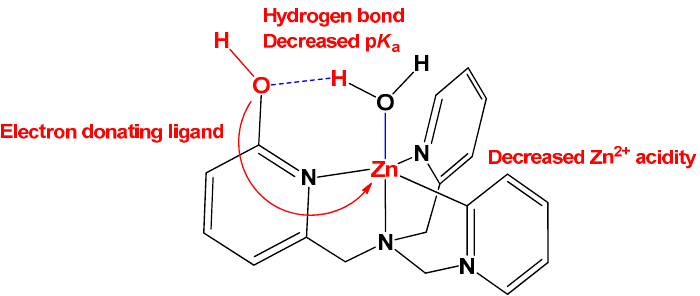
Figure 6. Schematic illustration of various effects by hydrogen bond mimicking.